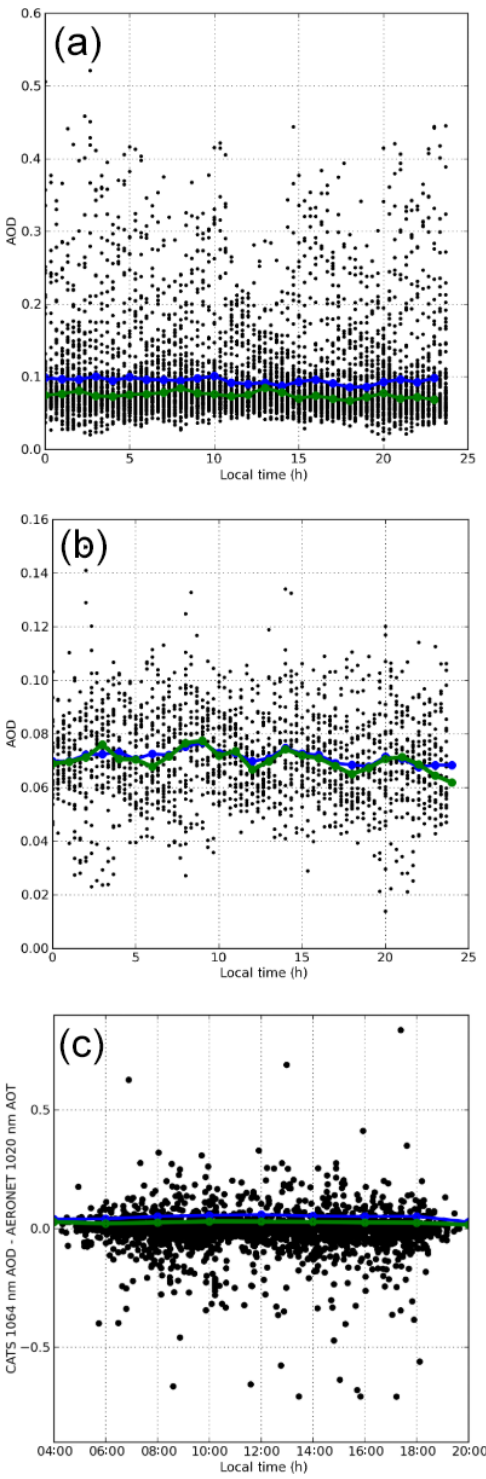
Figure 4. CATS 1064nm AOD (a) as a function of local time for the globe and (b) as a function of local time for areas south of − 25 ◦ . The difference between CATS 1064nm AOD and AERONET 1020nm AOD as a function of local time is shown in panel (c) . The mean is represented by the blue line, while the median is the green